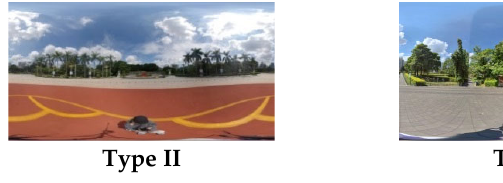
Figure 4. Clustering map of morning points.